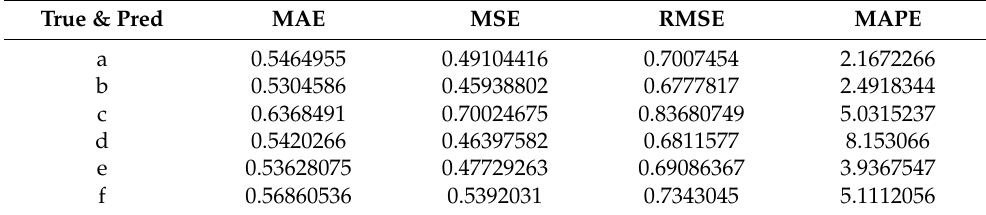
Table 1. Fault prediction result evaluation